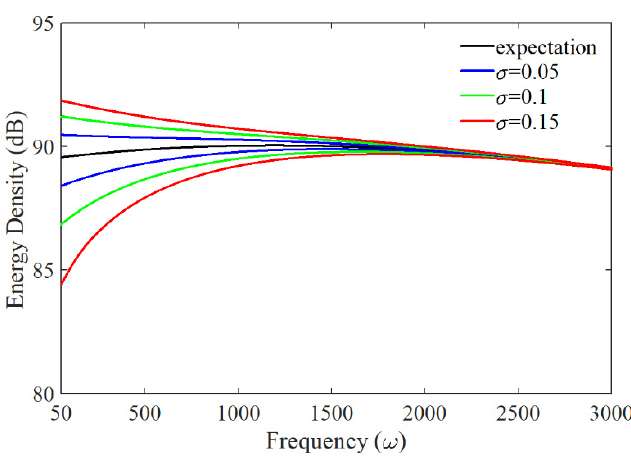
Figure 6. Energy response intervals of the membrane with a random length in frequency field. The reference energy is 10 − 12 J/m 2 .